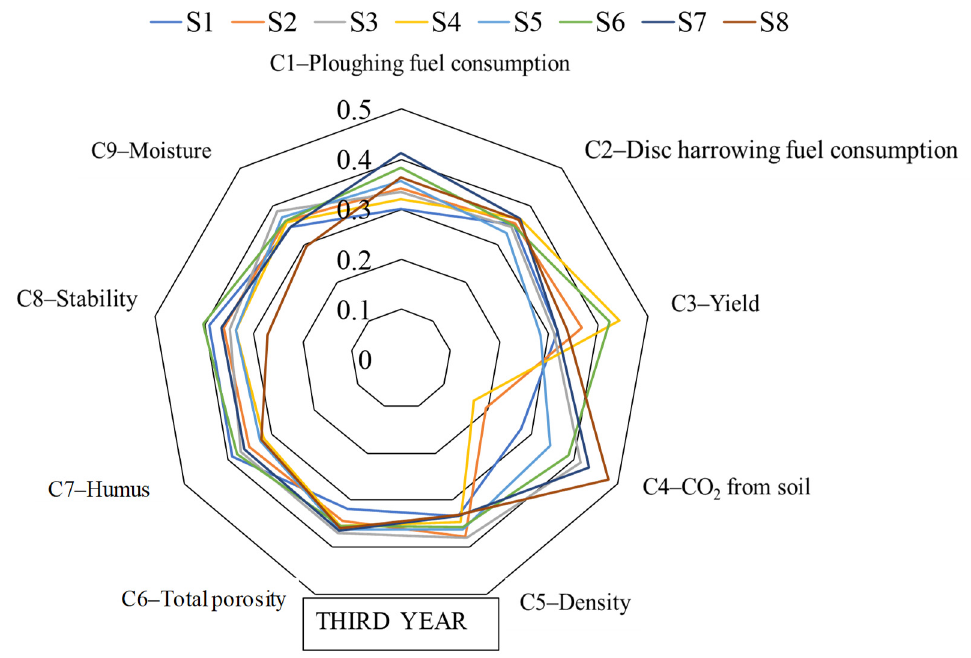
Figure 11. Multicriteria evaluation of the bio-impact effectiveness.